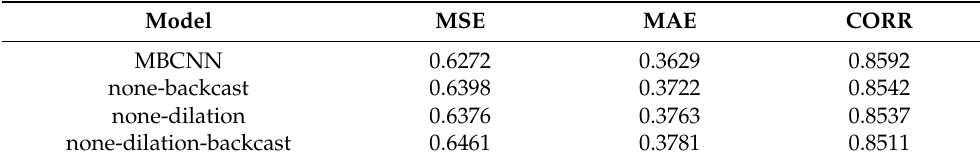
Table 3. Results of Ablation Experiments.